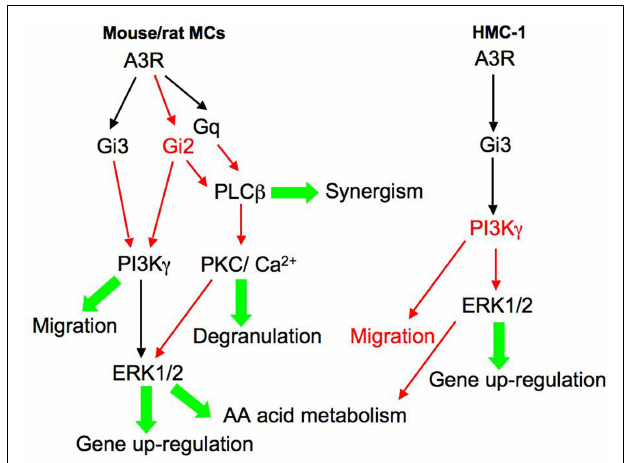
FIGURE 2 | Signaling pathways elicited by the human and rodentA3 adenosine receptor in MCs. This model aims to integrate the signaling pathways reported in the literature, where marked in red are proposed, not yet proven, pathways. According to this model, the rodent A3R couples to Gi2, Gi3, and Gq, leading to the activation of PLD, PLC β , and PI3K γ . As a result, the cytosolic concentration of Ca 2 + rises and protein kinase C (PKC) and the ERK MAP kinases are activated. According to this model, activation of PLC β mediates MC degranulation or synergizes with the Fc ε RI-elicited signals to potentiate degranulation. PI3K γ and ERK1/2 mediate respectively MC migration and class II and class III mediator formation. In contrast, the human A3R couples mainly to Gi3 leading to activation of ERK1/2 and gene